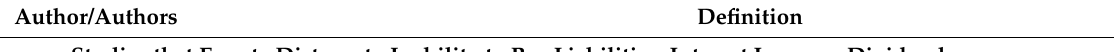
Table 1. Financial distress